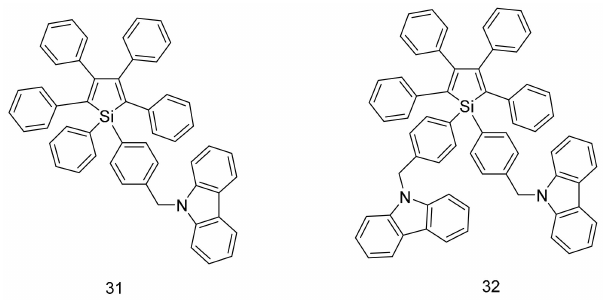
Figure 10. Structures of hexaphenylsilole molecules used as donors in